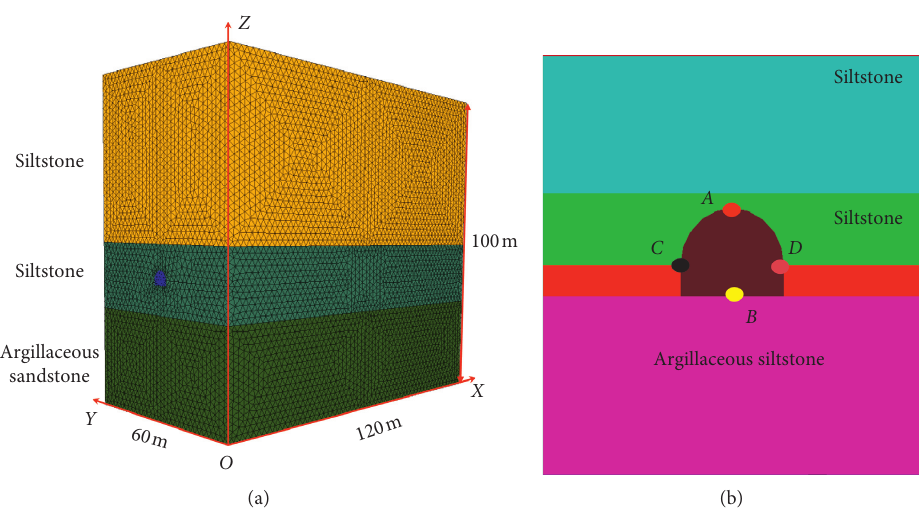
Figure 5: Numerical analysis. (a) Numerical calculation model. (b) Monitoring point